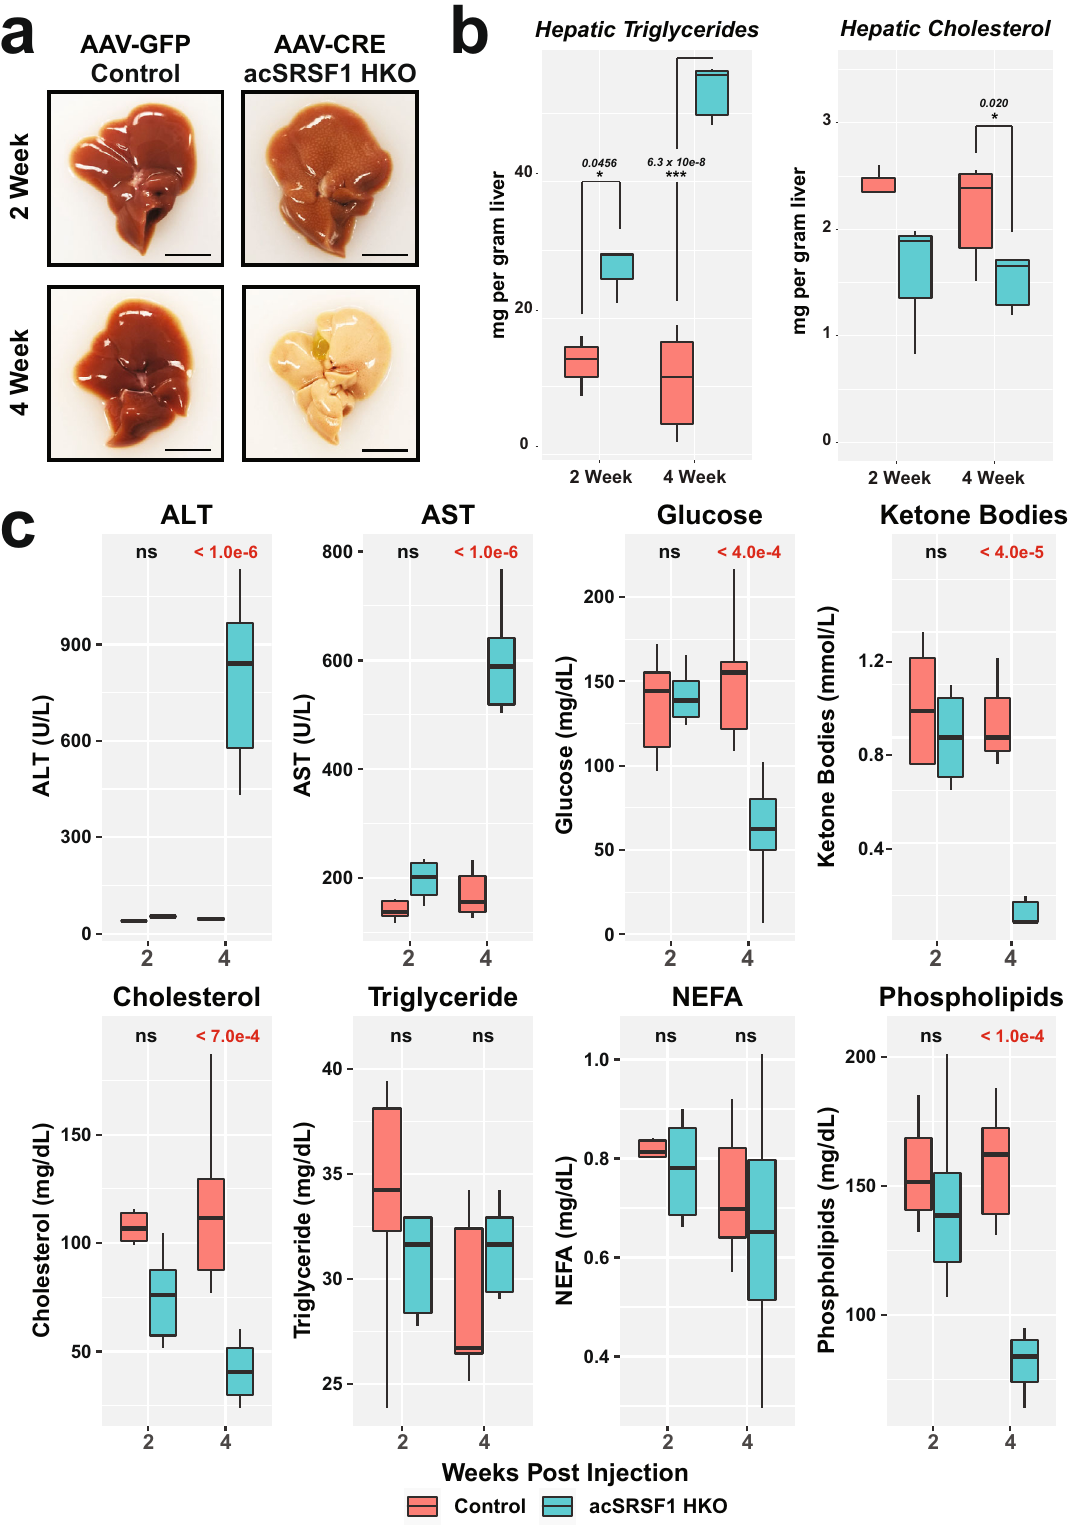
Fig. 6 | Acute SRSF1 HKO mice develop hepatic steatosis and liver damage. a Representativegrossimagesof whole liversharvested fromcontroland acSRSF1 HKO mice at the indicated timepoints. Scale bar = 1cm. b Box plot of measured hepatic triglyceride and cholesterol levelsin control and acSRSF1 HKO mice ( n =3 biologicallyindependent animalspergroup at2weeks; n =6 and 5for controland acSRSF1 HKO at 4 weeks, respectively). A two-tailed Student t-test was performed to test for signi fi cance. Signi fi cant differences are denoted by “ * ” with the p-value